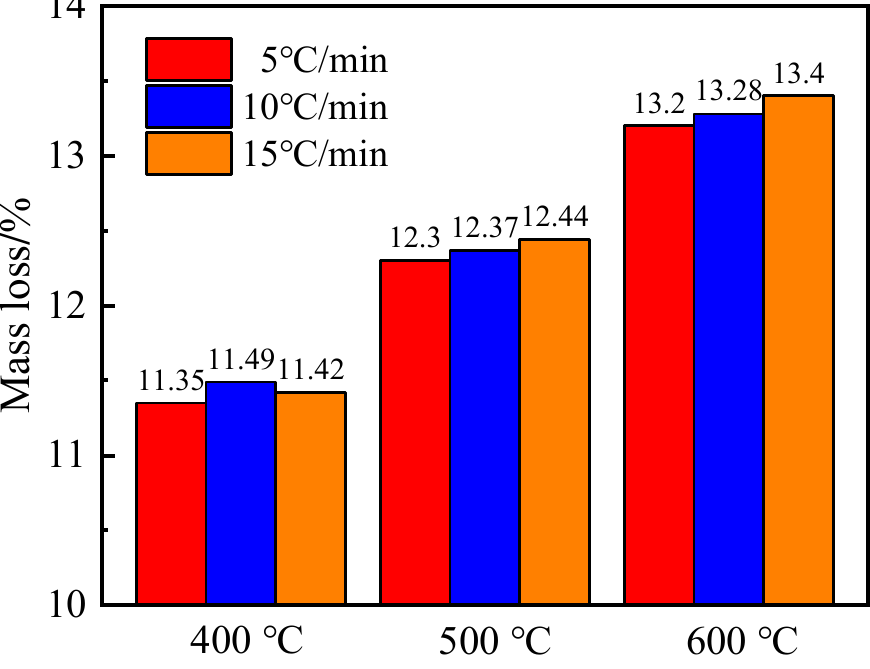
Figure 2. Effect of heating rate on the mass loss of mortar.